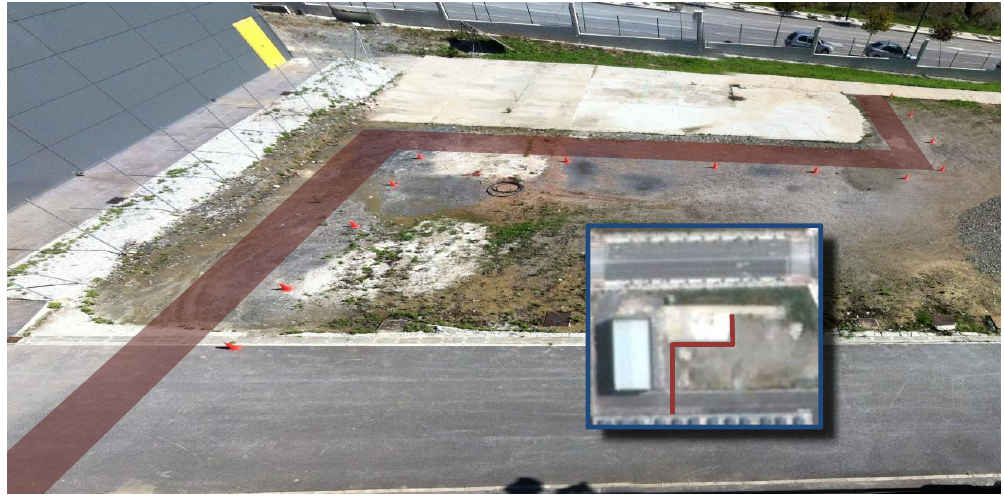
Figure 6. View of the experimental site where the lane has been highlighted in red. Inset: Satellite